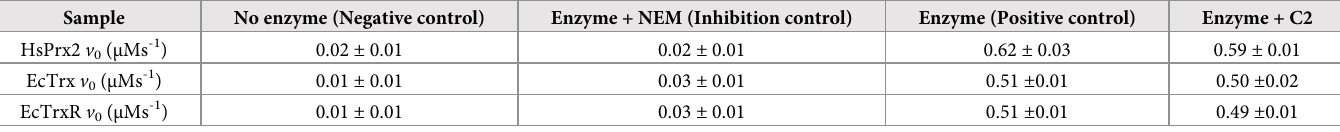
Table 3. Initial rates of peroxide decomposition after treatment with compound C2 of HsPrx2, EcTrx and EcTrxR.